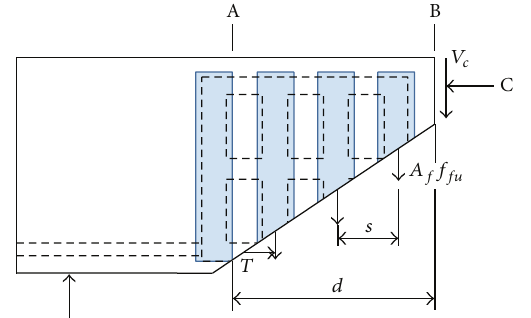
Table 2: Maximum loading and shear strength test results.